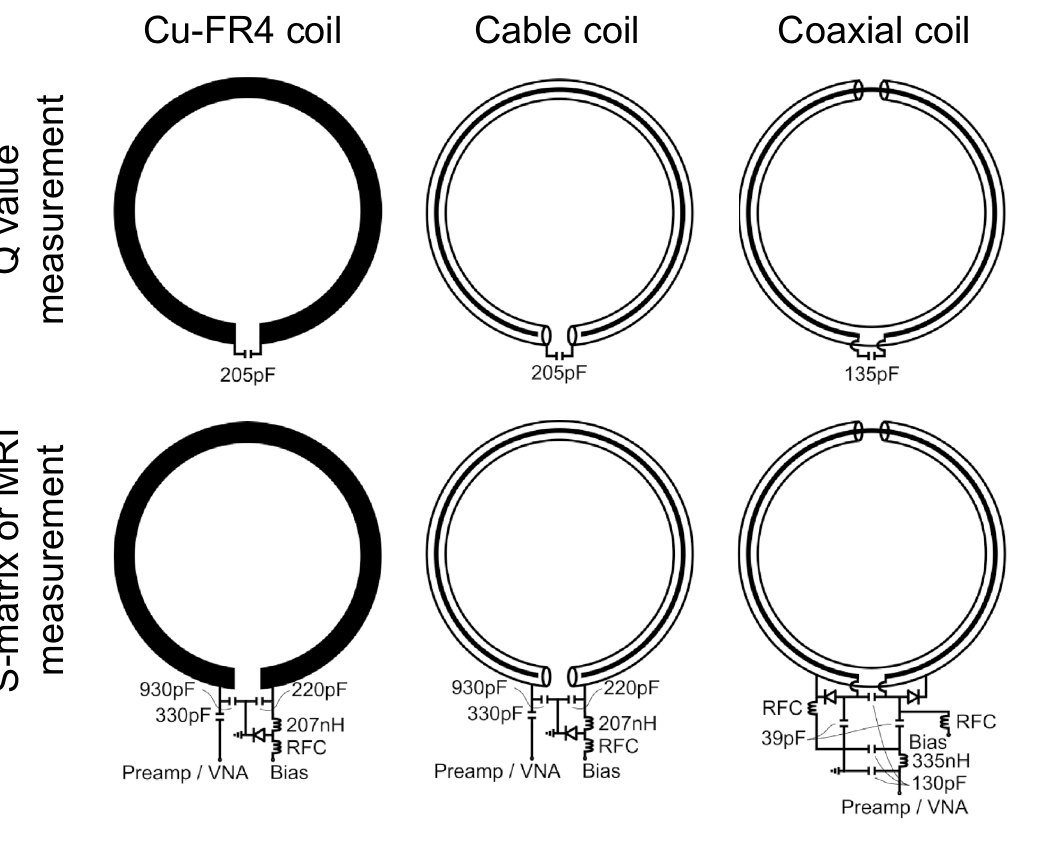
Figure 1. Coil schematics for Q measurements (top row) and S-matrix or MRI measurements (bottom row). A fuse was installed (not shown) in loops used for in vivo experiments. VNA: vector network analyzer. RFC: radiofrequency